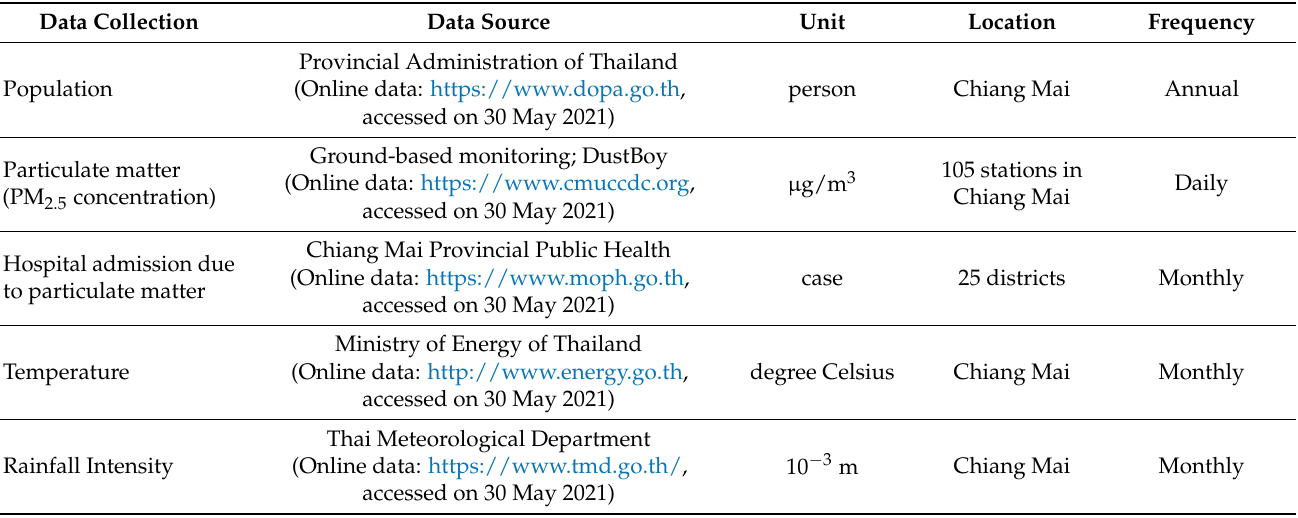
Table 1. Details of data and